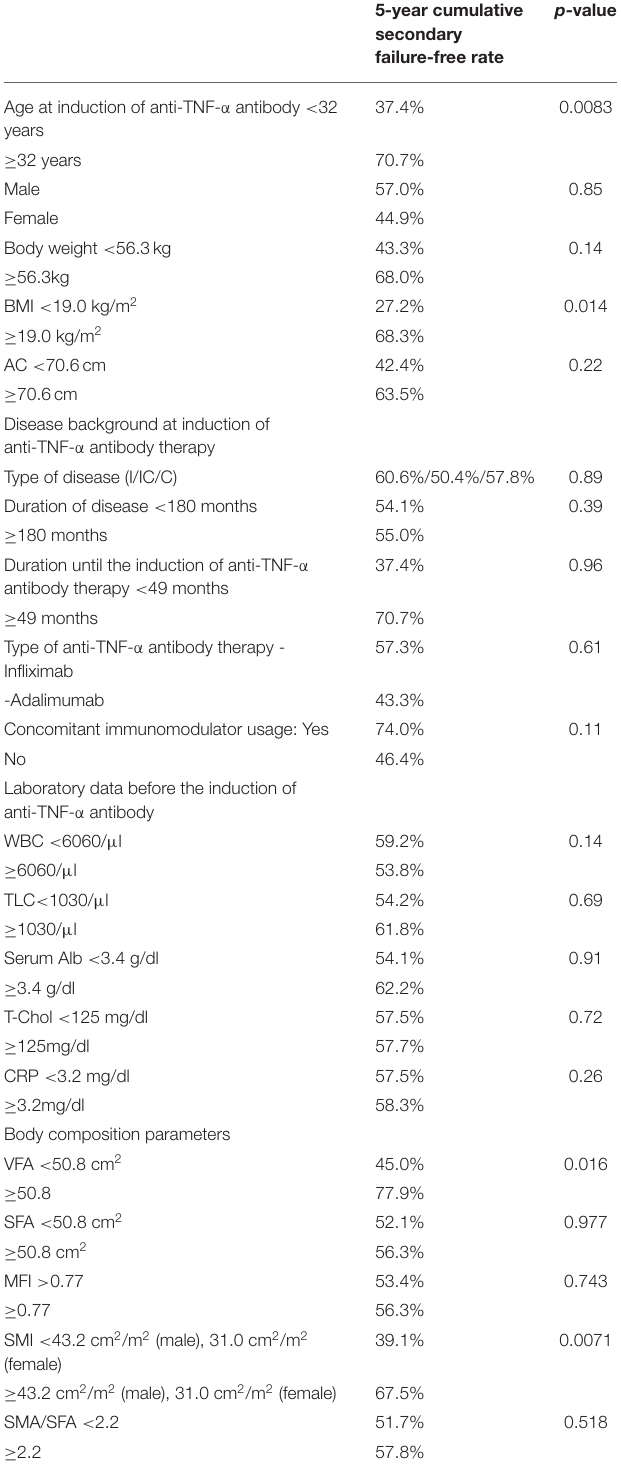
TABLE 2B | Multivariate analyses of factors associated with secondary failure during anti-TNF therapy (Cox proportional hazards analysis). Multivariate